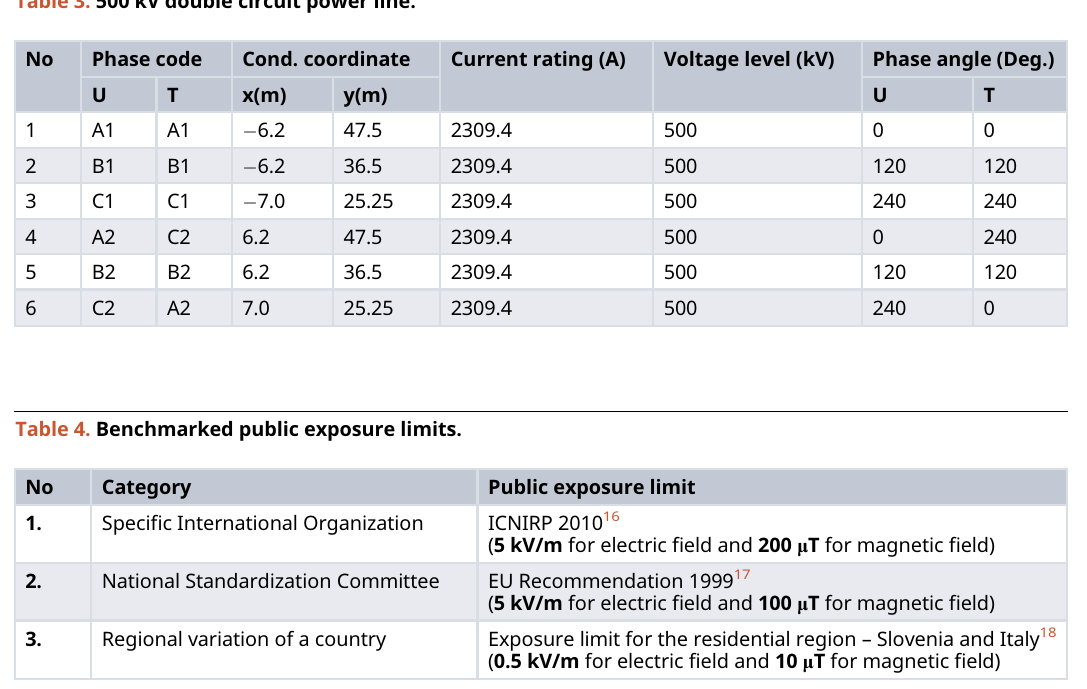
Table 3. 500 kV double circuit power line.